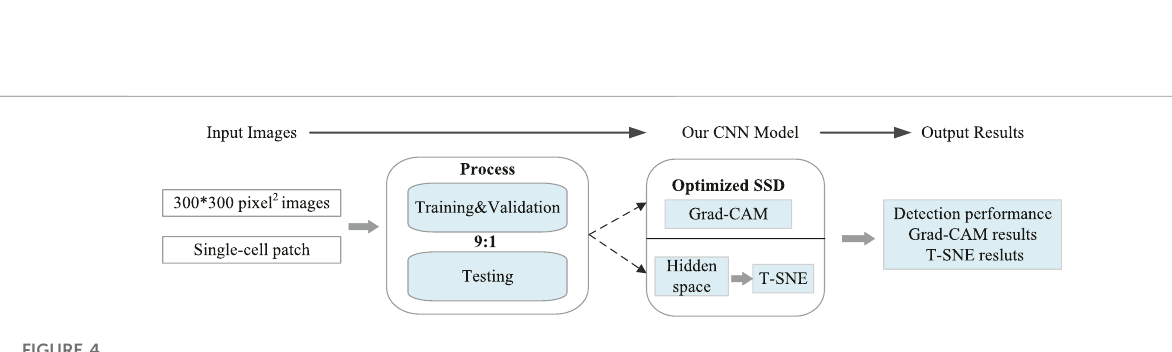
FIGURE 4 Overview of the generated CNN model for automated